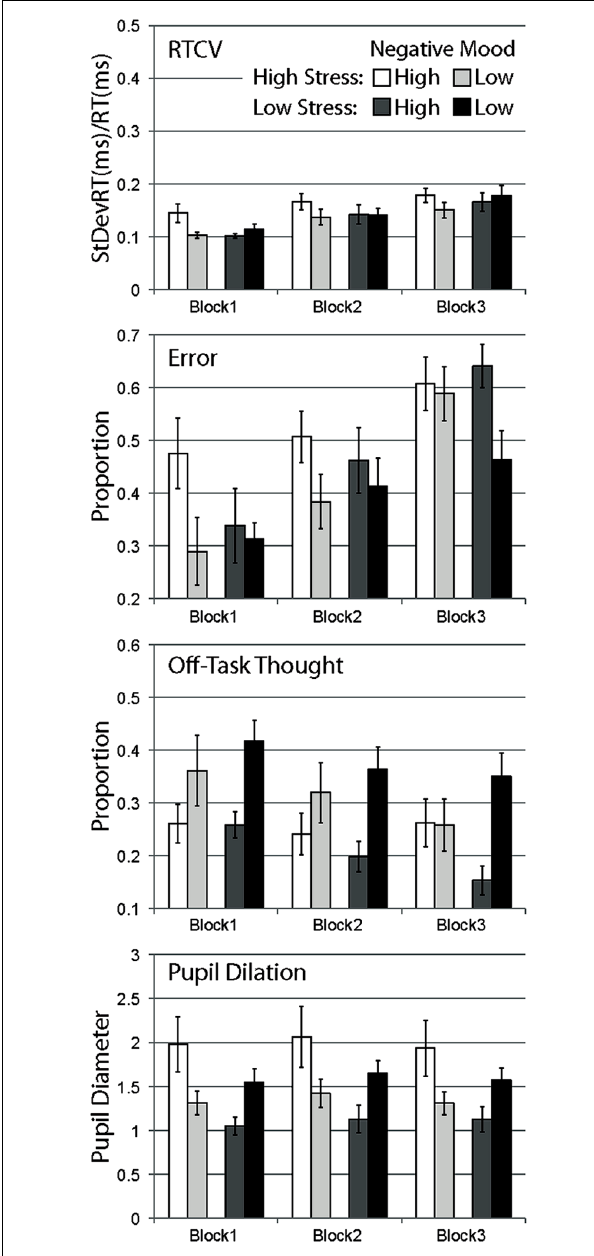
FIGURE 2 | Mean data for Experiment 2, separated by stress manipulation, negative mood group, and block. Data are shown for RTCV (reaction time coefficient of variability, calculated as reaction time standard deviation divided by the mean), error (proportion of commission errors on no-go trials), proportion of probe trials reporting off-task thought, and pupil diameter. Error bars represent standard errors.